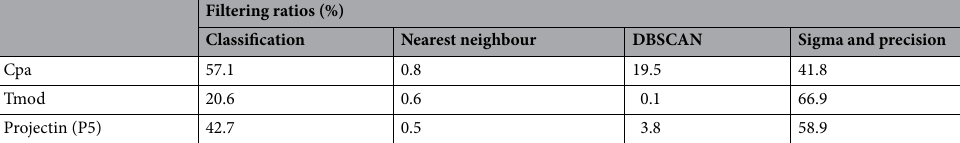
Table 1. The ratio of the discarded localization number compared to the total number of localizations in each subsequent filtering step.